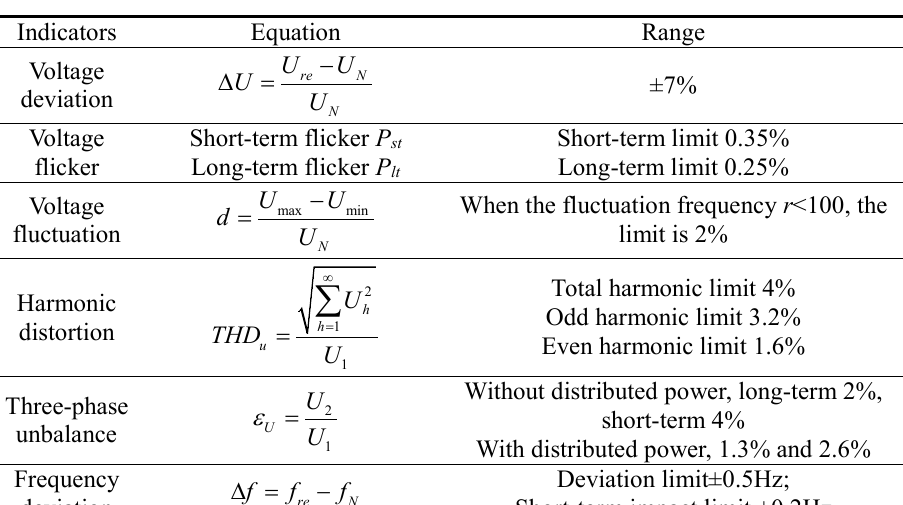
Table 1. 10kV power quality